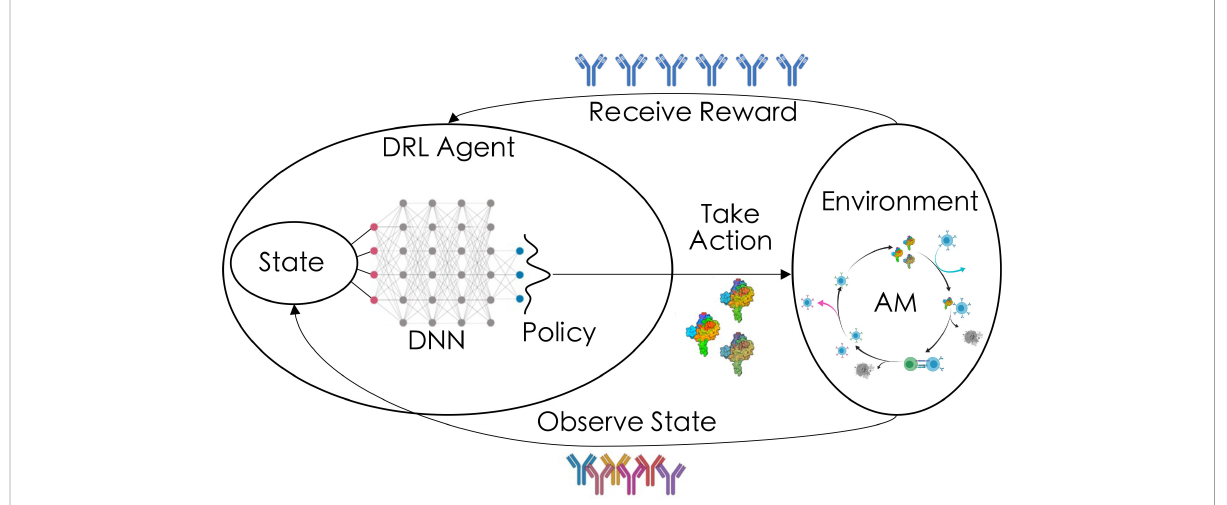
FIGURE 1 Overview of how deep reinforcement learning (DRL) is coupled to the agent-based model of af fi nity maturation (AM) in the current work. The DRL agent chooses an action (here, the level of vaccine-imposed frustration, modulated by changing antigen sequence and/or concentration) that is fed into the environment (here, the AM process), after which the agent observes the state of the system (here, properties of the vaccine-induced memory B cell receptor/antibody population). The agent then receives a reward based on how well the observed state meets a user-de fi ned reward metric (here, the quality and quantity of the resulting plasma B cell receptor/antibody population). Over time, the agent learns a robust mapping between the states and actions, leading to an optimal policy (here, a vaccination/temporal frustration protocol) for maximizing the chosen